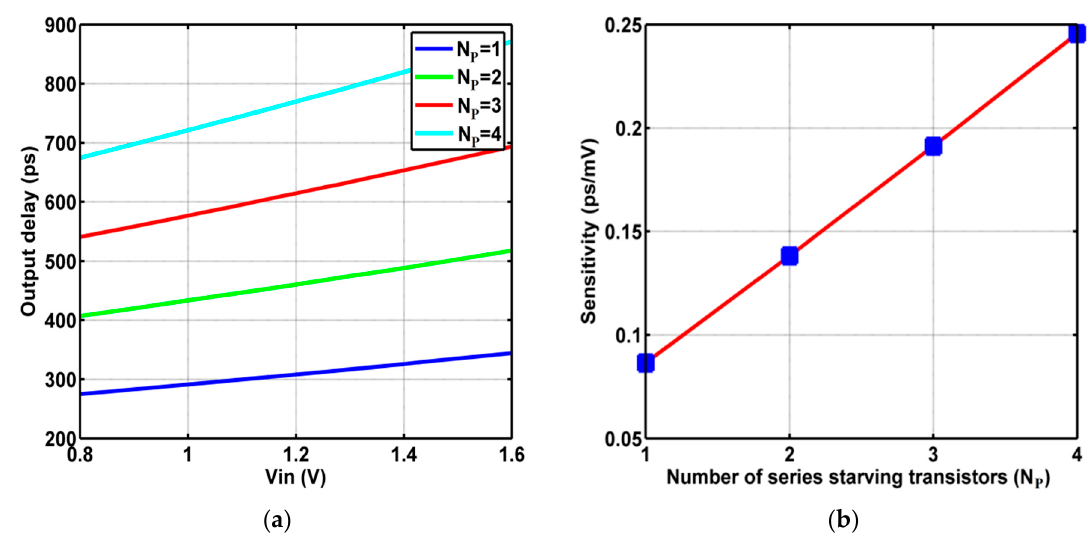
Figure 6. ( a ) Output delay versus number of series starving transistors (N P ), and ( b ) sensitivity versus number of series starving transistors (N P ).